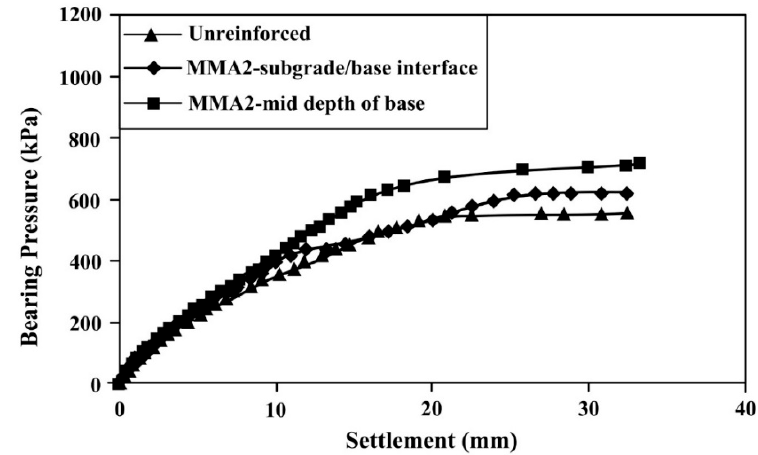
Figure 7. Variation in bearing pressure and settlement for a 267-mm-thick base under monotonic load tests (modified from Subaida et al. [38]).